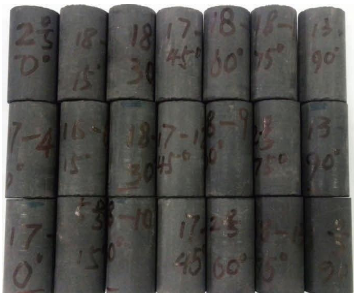
Figure 2: Prepared shale specimens. Te 7 specimens in the frst row were used for the test 1 at scCO2 condition; those in the second row were used for the test 2 with N 2 at the same temperature and pressure condition as test 1; those in the third row were used for the test 3 with helium gas at the same temperature as test 1.